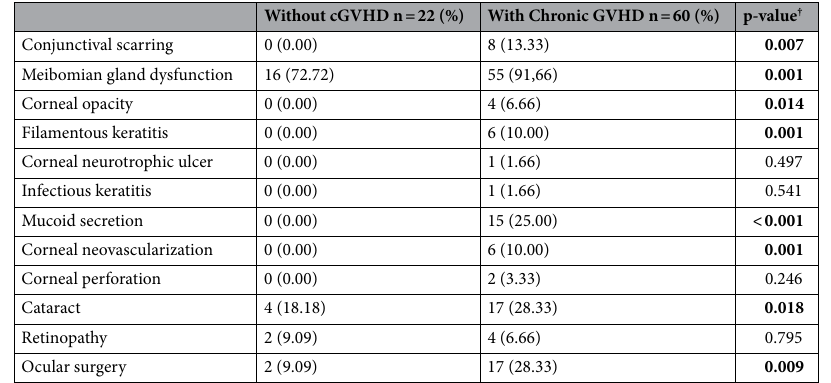
Table 3. Ocular manifestations among patients with and without graft-versus-host disease. Data expressed as frequency of cases in the study sample. † Chi-square test; GVHD: Graft-versus-host disease. Significant values are in [bold].